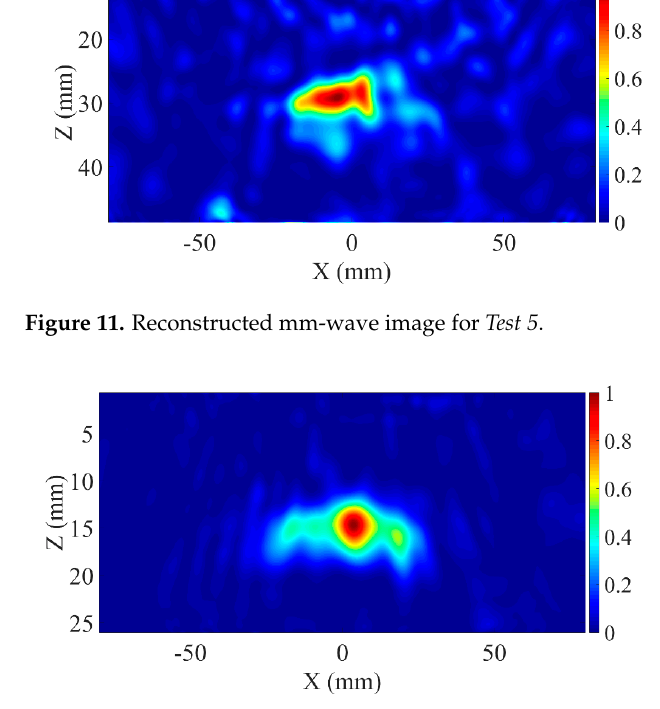
Appl. Sci. 2021 , 11 , x FOR PEER REVIEW Figure 10. Reconstructed mm-wave image for Test 4 . Figure 10. Reconstructed mm-wave image for Test 4 .